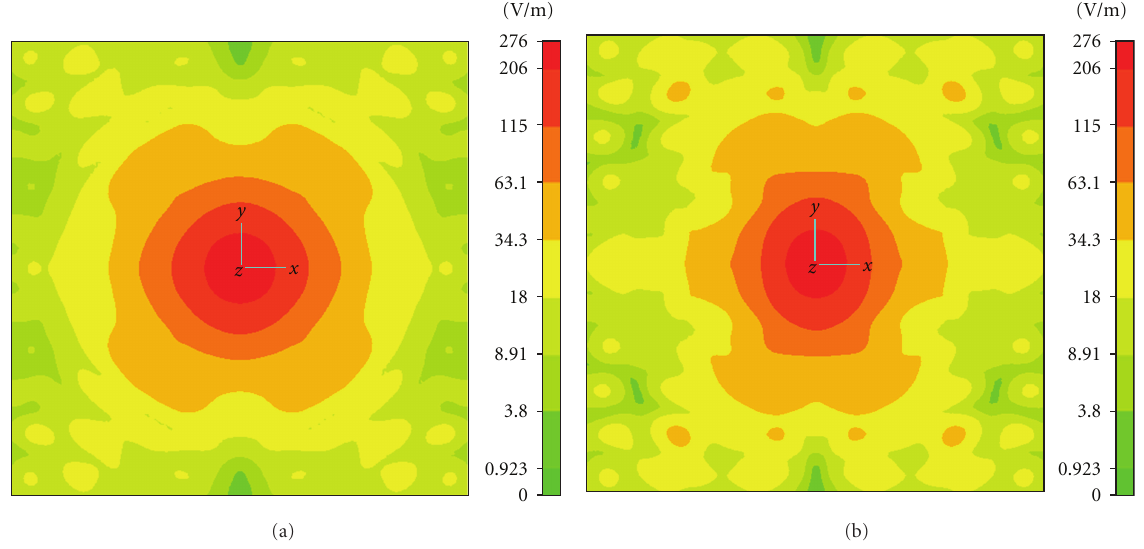
Figure 11: E-field distribution above antenna at 5.05 GHz with one horn (a) and with 7 horns (b).